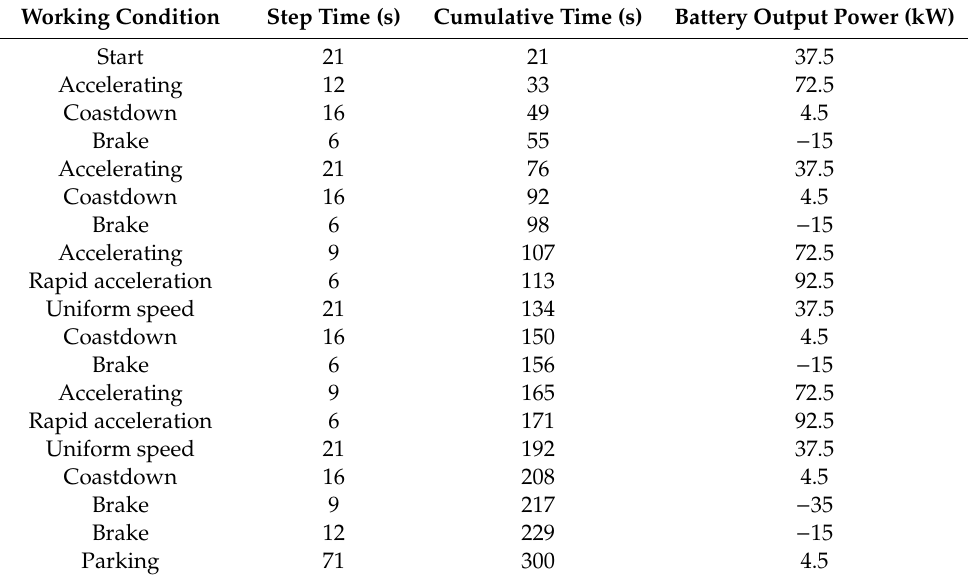
Table 2. The BBDST working